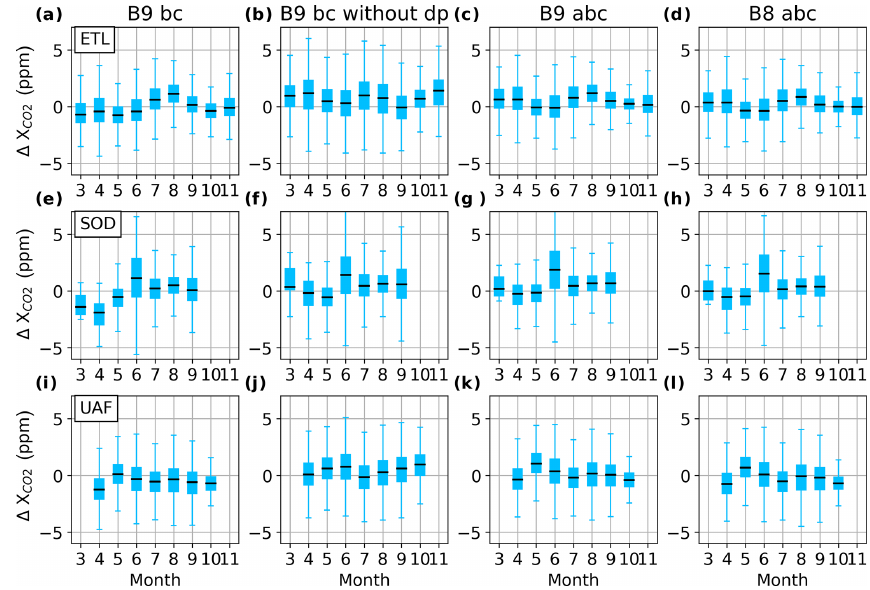
Figure 14. Box plots of distributions of monthly biases at each boreal forest site and filtered by boreal QC, given the standard B9 bc (Eq. 4), given the B9 bc without the dpfrac term, given the B9 abc (Eq. 6), or given the B8 abc (Eq. 7). Note that bias is defined as ( (cid:49)X CO (OCO-2 retrieval) i − ( ˜ X NNG ) i ) for each coincident OCO-2